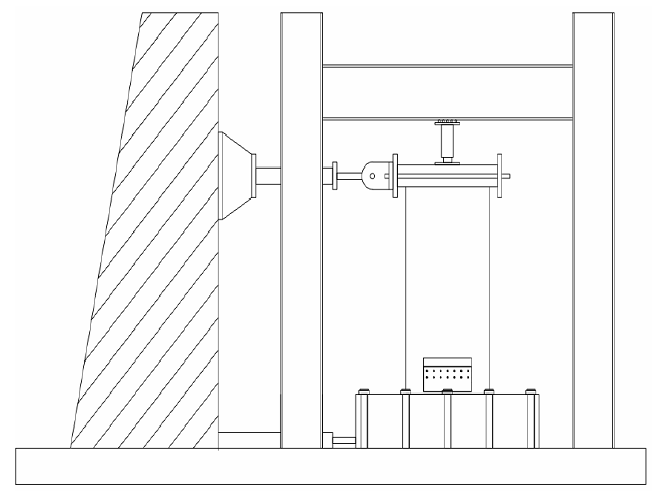
Figure 3. Test setup. Table 1. Material properties of concrete.